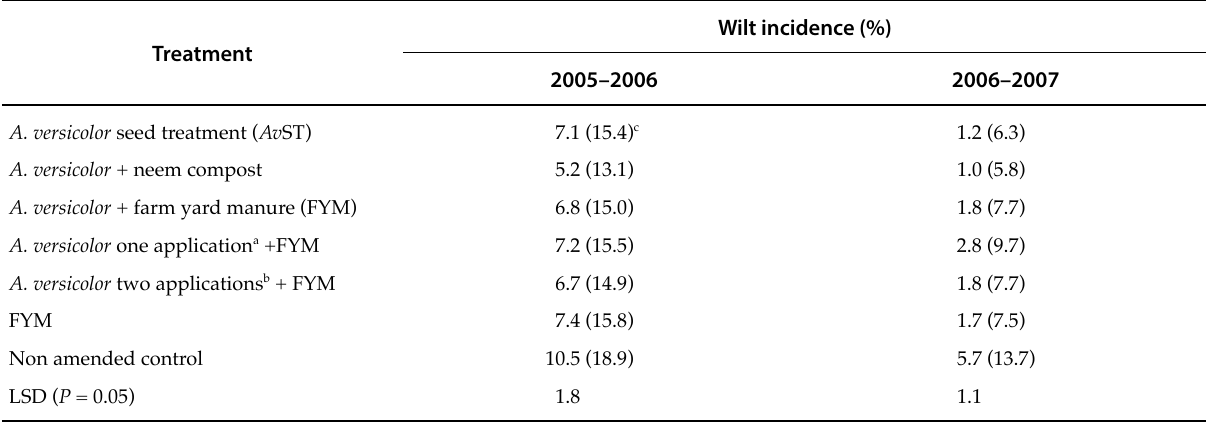
Table 5. Mean incidence of cumin wilt in field plots in two growing seasons, treated with the biocontrol agent Aspergillus versicolor applied using different methods and with different soil